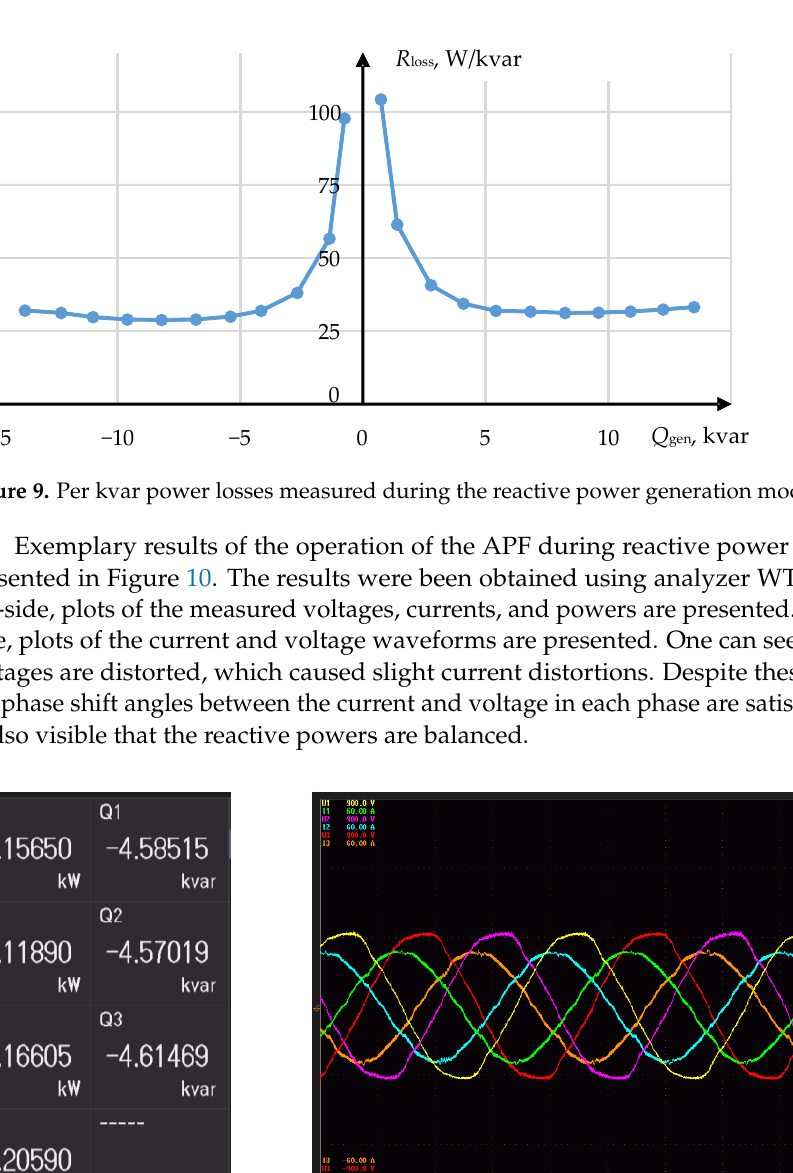
Figure 8. Power losses measured during the reactive power generation mode.